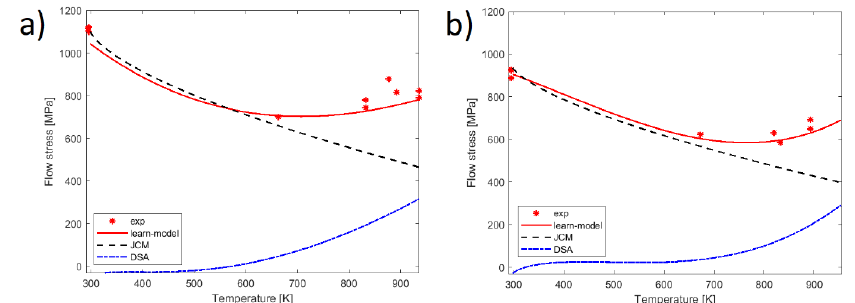
Figure 2: Flow stress as a function of temperature at 20% strain and 4500 𝑠 −1 predicted by the SVM model, the JCM, and the DSA component of the flow stress in a) reference structure and b) globular pearlite structure